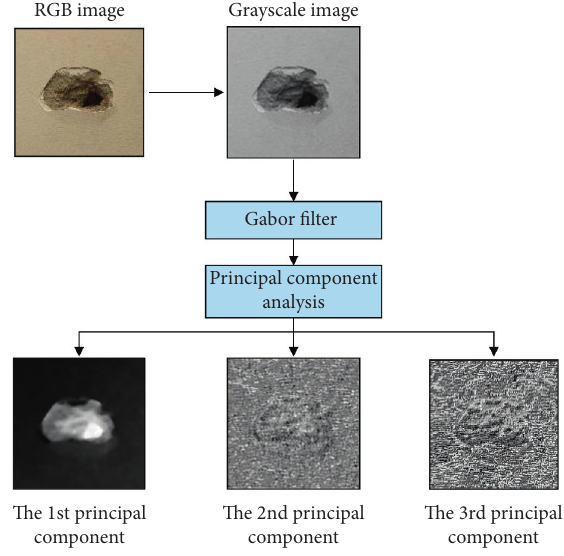
Figure 5: Image processed by the Gabor